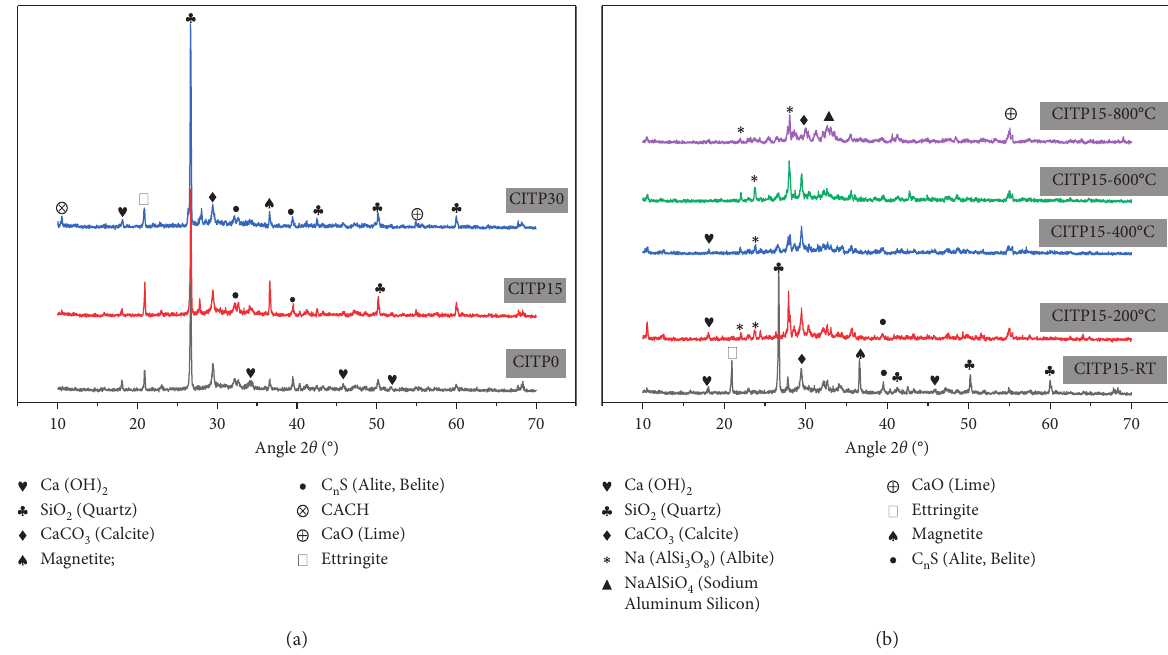
Figure 5: XRD patterns of concrete: (a) the reference sample CITP0, CITP15, and CITP30 at RTand (b) the sample CITP15 after exposure to high temperatures.